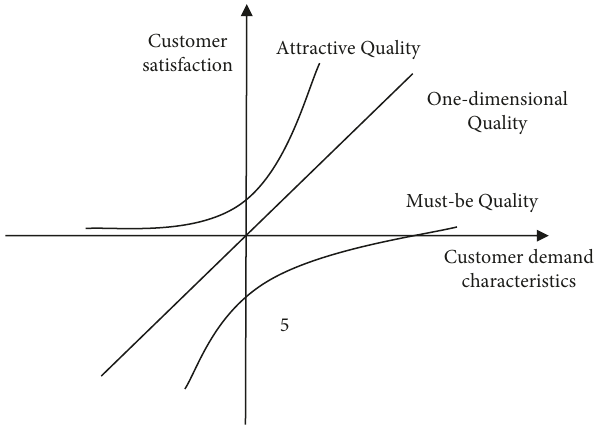
Figure 2: The model diagram of